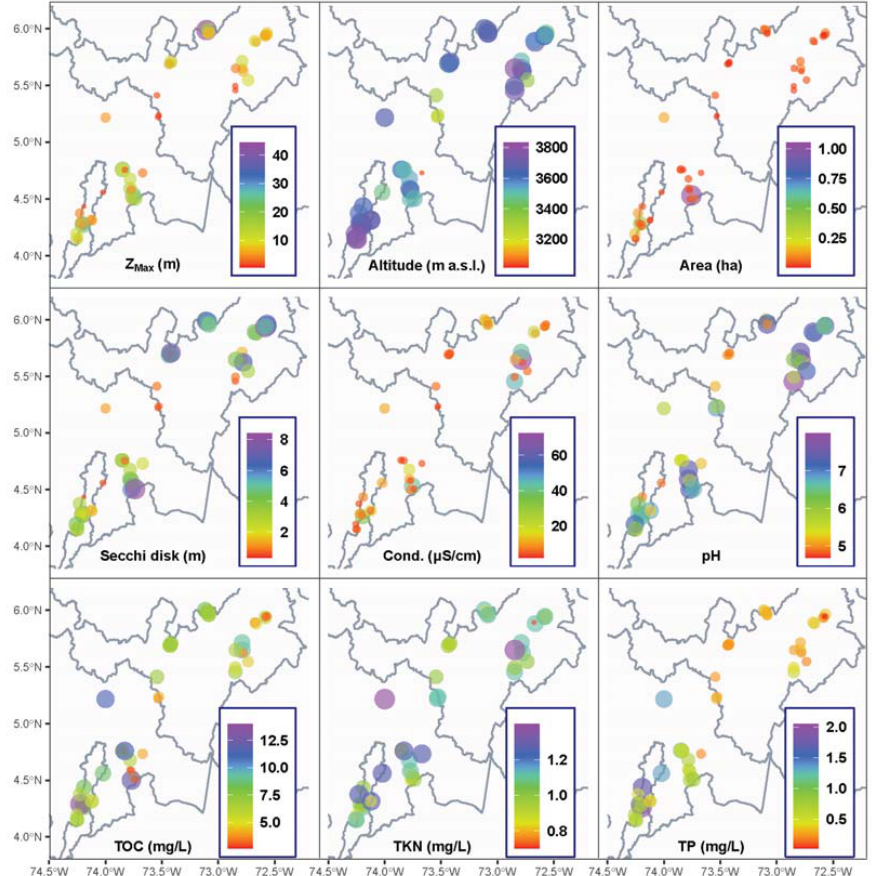
Figure 4. Spatial variation of geographical, geomorphological, physical and chemical variables of the 51 lakes sampled.